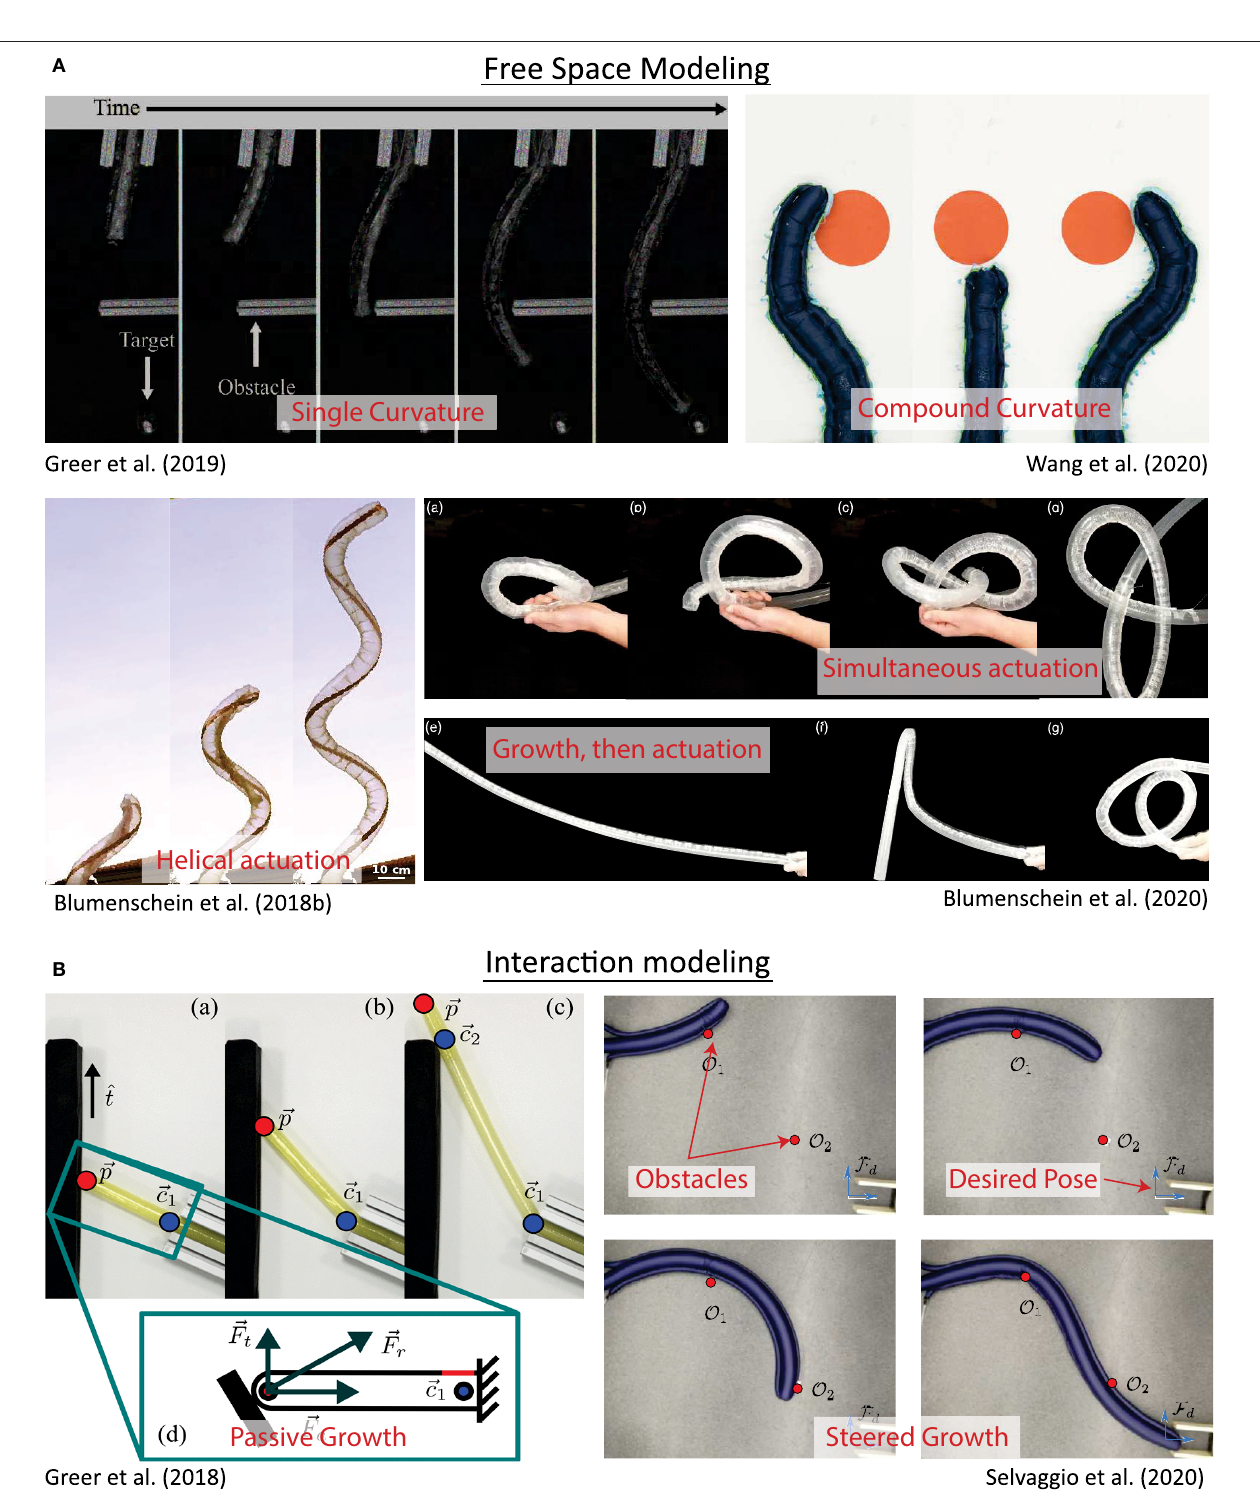
FIGURE 8 | Kinematic and force-balance modeling of everting vine robot shape/steering. (A) Modeling of robot shape in free space has included kinematic models based on constant curvature and piecewise constant curvature sections, some of which also consider forces, as well as kinematic models based on helical and piecewise helical actuator routings. (B) Modeling of robot shape during environment interaction has developed heuristics for both passively and actively steered growth based on kinematics and force-balance models. Modified from Greer et al. (2019). The publisher for this copyrighted material is Mary Ann Liebert, Inc. publishers. Modified from Wang et al. (2020) © IEEE 2020, Blumenschein et al. (2018b) © IEEE 2018, Greer et al. (2018), Blumenschein et al. (2020) © IEEE 2018, and Selvaggio et al. (2020) © IEEE 2020.